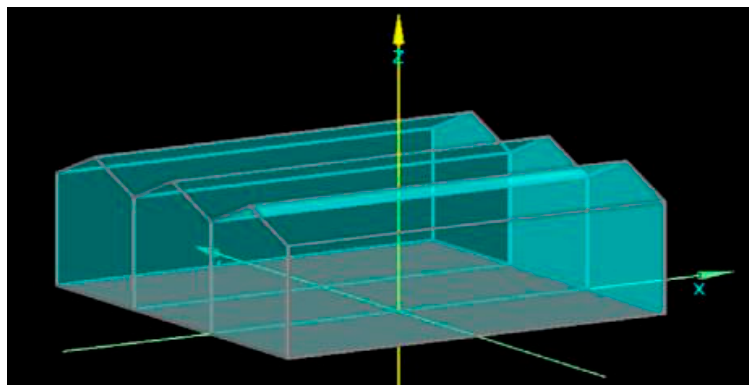
Figure 6. Venlo greenhouse designed with the simulation software.